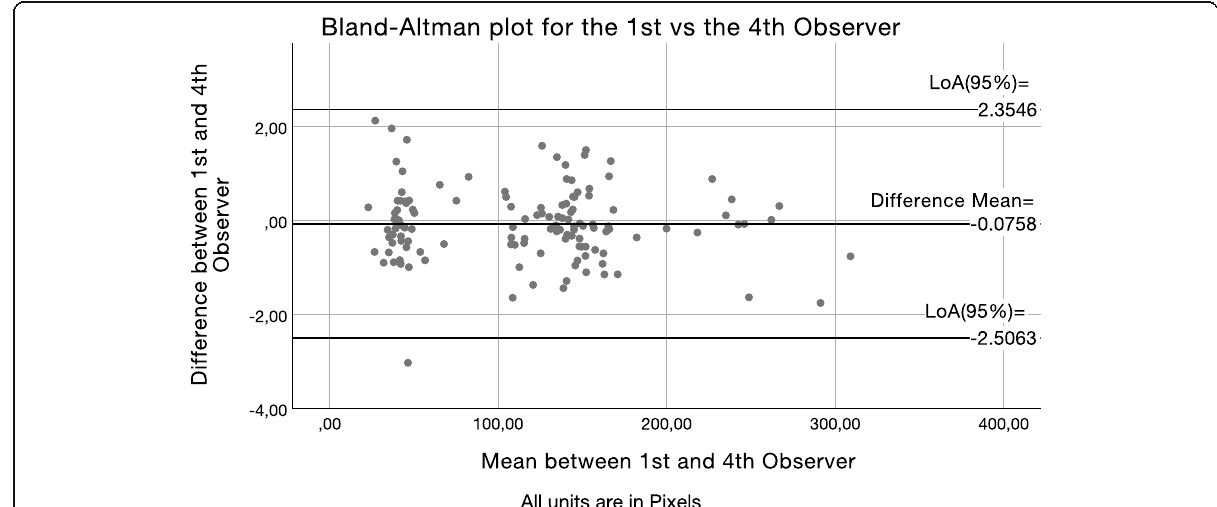
Fig. 6 Bland – Altman scatter plot of the difference between first observer ’ s average measurements versus the fourth observer ’ s (C). Y -axis: Difference between the first observer and the fourth observer (C). X -axis: Average of their measures. Difference mean: Estimated bias between the first observer and the fourth observer (C) respectively. LoA 95% limits of agreement at the 95% confidence